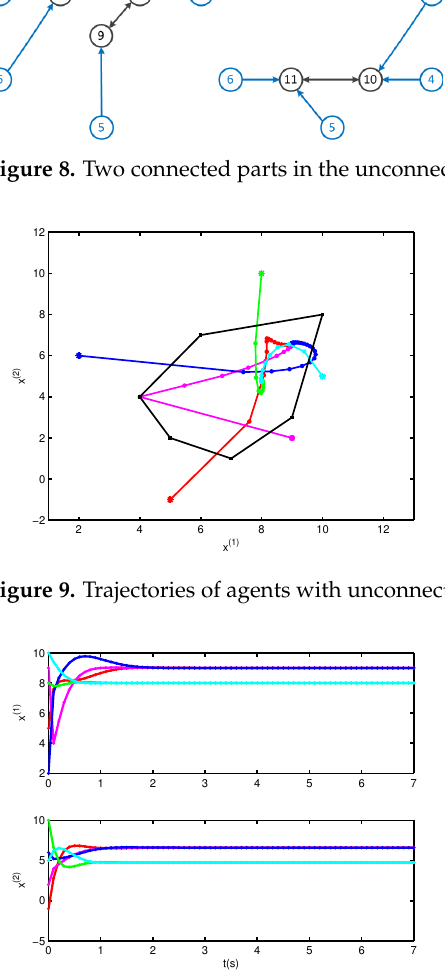
Figure 10. States of followers with unconnected